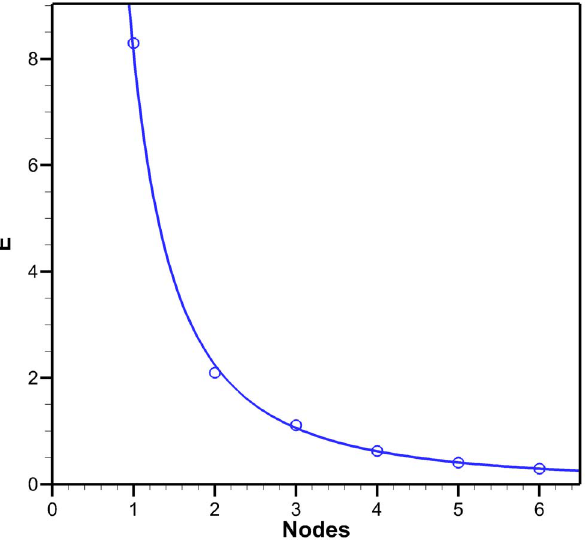
Fig. 9. Error as a function of segments. Error (E) for different number of segments found by the error analysis method. The data has been fitted with power curves with equations E ~ 8 : 11 L { 1 : 85 determination of R 2 ~ 0 : 999 for the optimized